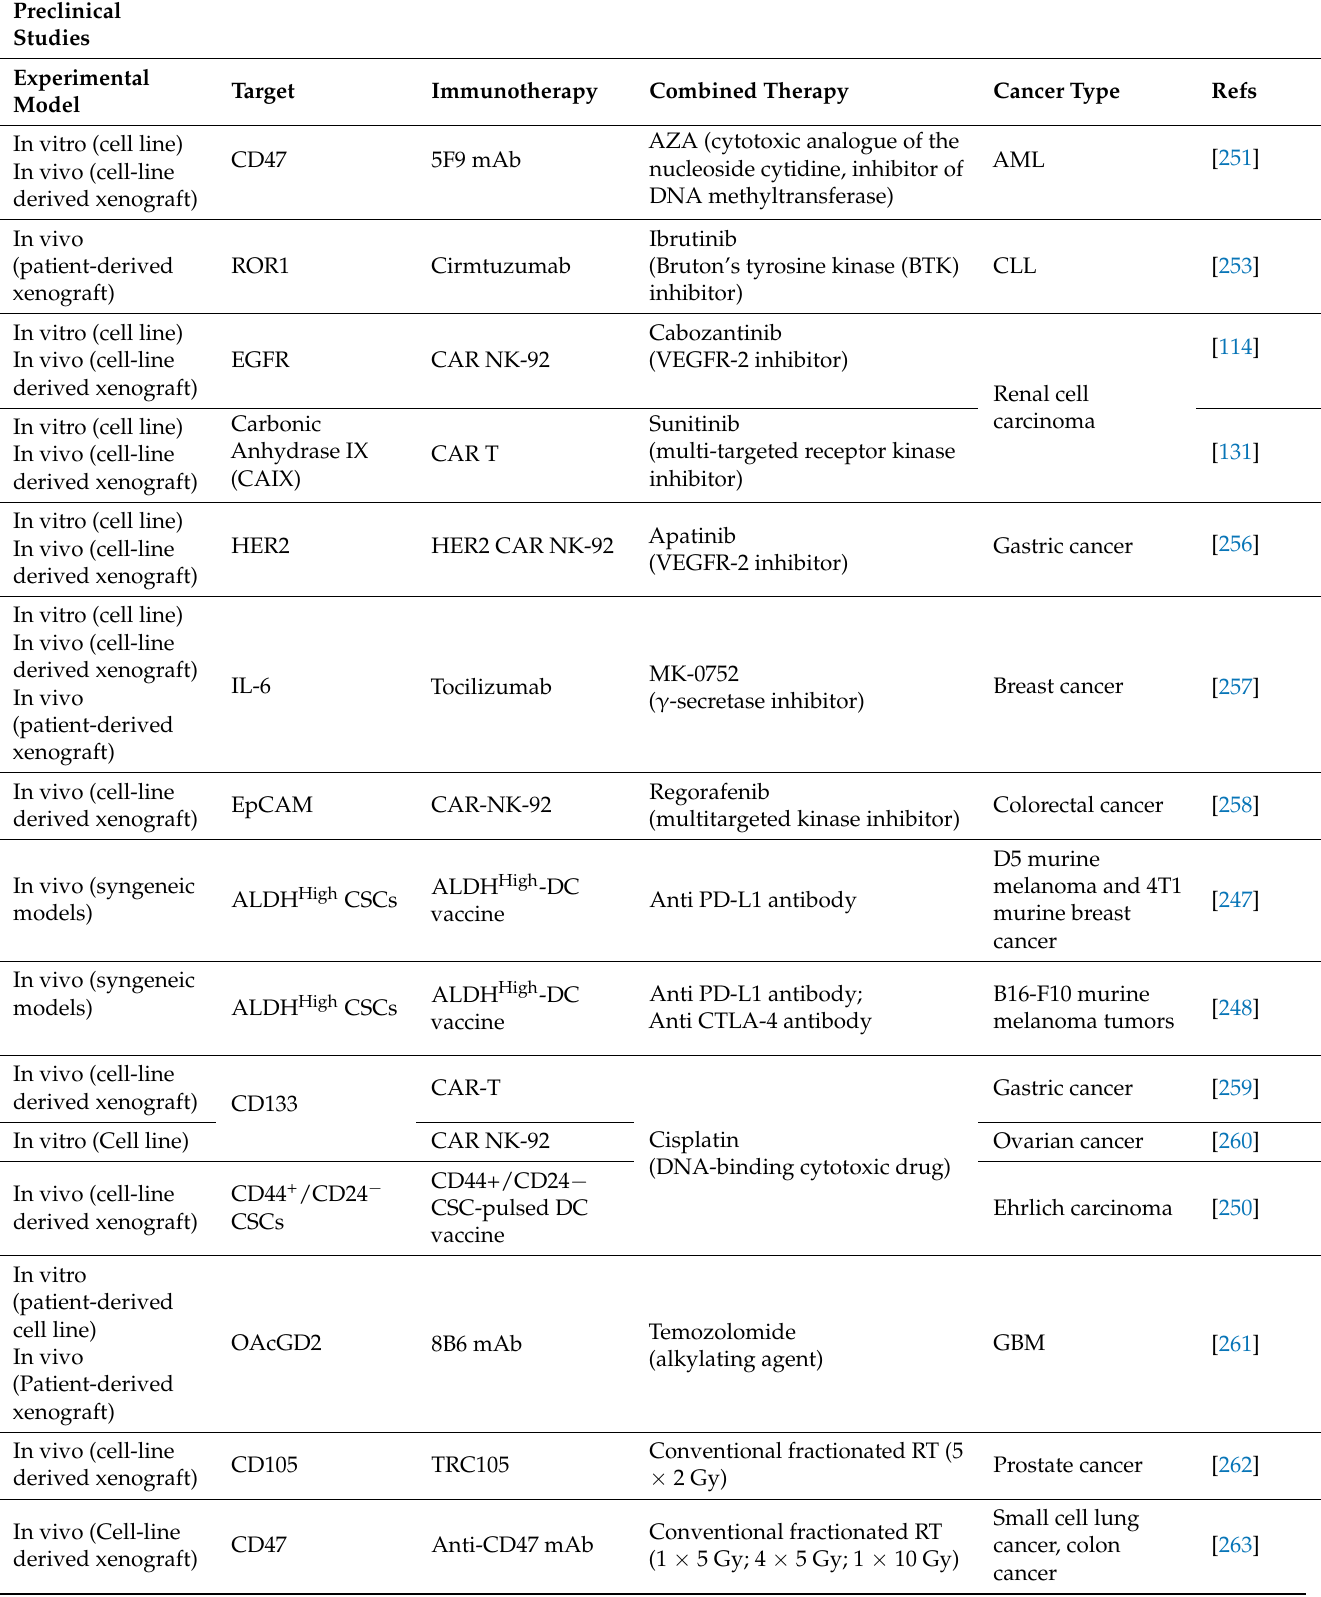
Table 3. Preclinical/clinical trials of combination therapies targeting CSC